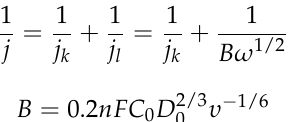
Figure S4. SEM images of Fe-N-C-900; Figure S5. SEM images of Fe-N-CNSs-15; Figure S6. SEM images of Fe-N-CNSs-60; Figure S7. TEM images of Fe-N-CNSs; Figure S8. High-resolution C 1s spectrum of N-CNSs; Figure S9. High-resolution C 1s spectrum of Fe-N-CNSs; Figure S10. High- resolution C 1s spectrum of Fe-N-C; Figure S11. High-resolution Fe 2p spectrum of Fe-N-CNSs; Figure S12. Raman spectra of the synthesized materials; Figure S13. N 2 adsorption-desorption isotherms of Fe-N-CNSs-800, Fe-N-CNSs-900 and Fe-N-CNSs-1000; Figure S14. The pore size distribution of Fe-N-CNSs-800, Fe-N-CNSs-900 and Fe-N-CNSs-1000; Figure S15. LSV curves of Fe-N-CNSs-800, Fe-N-CNSs-900, Fe-N-CNSs-1000; Figure S16. LSV curves of Fe-N-CNSs-15, Fe-N-CNSs-30, Fe-N- CNSs-60; Figure S17. Nyquist plots of electrochemical impedance spectroscopy (EIS) for Fe-N-CNSs and Pt/C; Figure S18. Poison experiment by KSCN; Table S1. Comparison of ORR activity of various Fe-N-C catalysts; Table S2. Comparison of the performance of the primary zinc-air batteries with the present